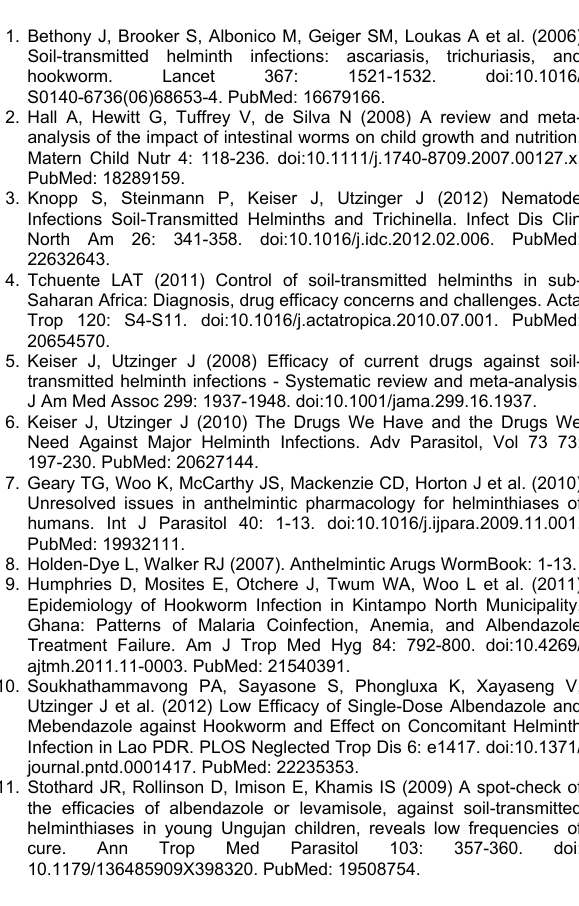
Figure S4. Intoxication of Heligmosomoides bakeri adults in vitro using five doses of either albendazole (ALB), (PYR). Parasites were scored daily for motility on a scale of 3-0. Data are from the same experiments in Figure